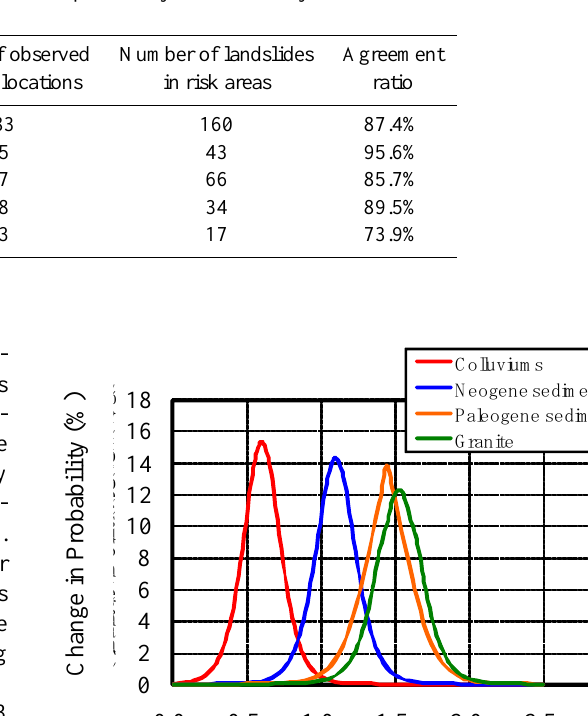
Fig 10 Variation in landslide hazard probability with change in hydraulic gradient for 350m relief energy